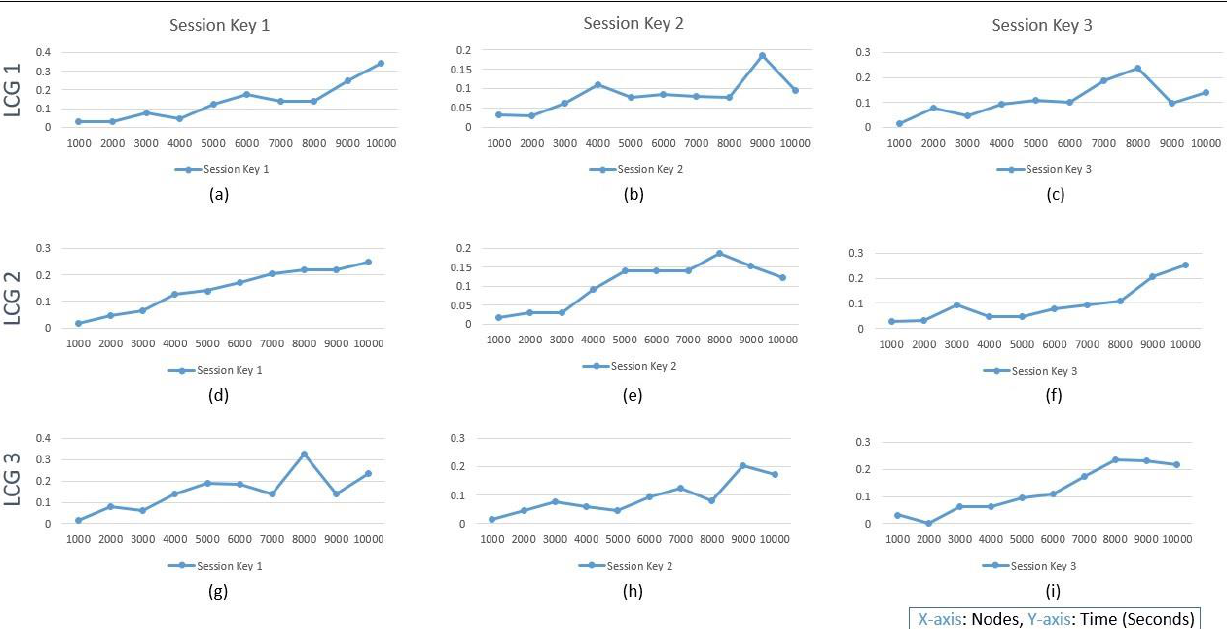
Figure 5. LCG-based session key generation: LCG 1 GCC ( a ) session key 1, ( b ) session key 2, ( c )